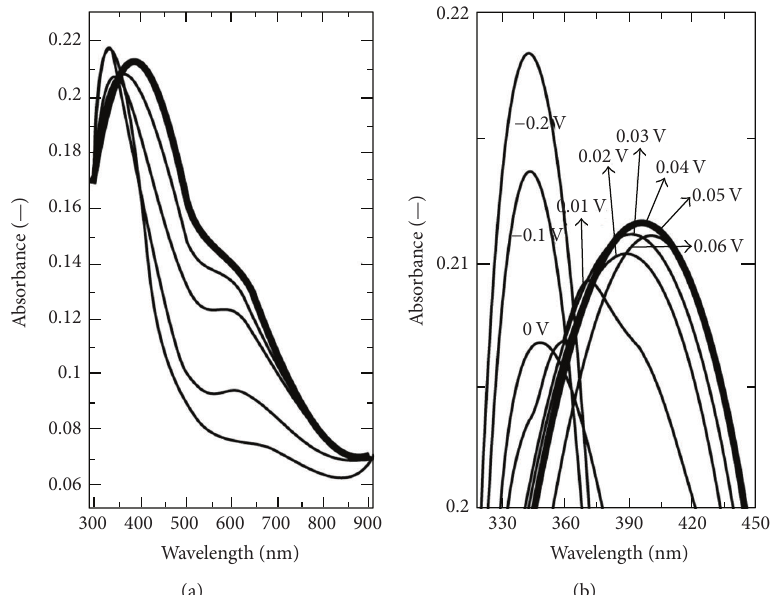
F 21: (a) In situ �V-Vis spectra of POAP at different applied electrode potentials. e POAP �lm was prepared on I�O-coated glass at 0.8V (1h electrolysis) from a solution containing 0.05M o -AP in 0.5M H